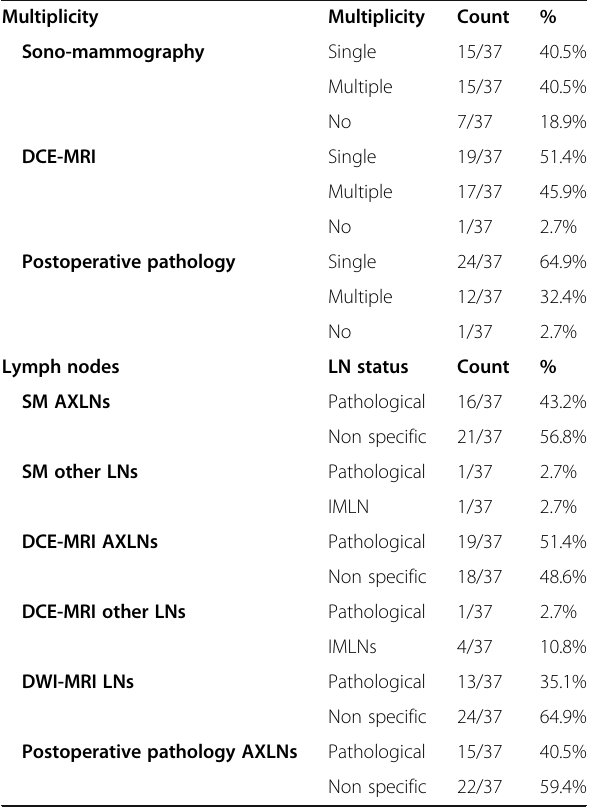
Table 2 Table showing multiplicity and axillary lymph nodes status by the different imaging modalities in upfront surgery group